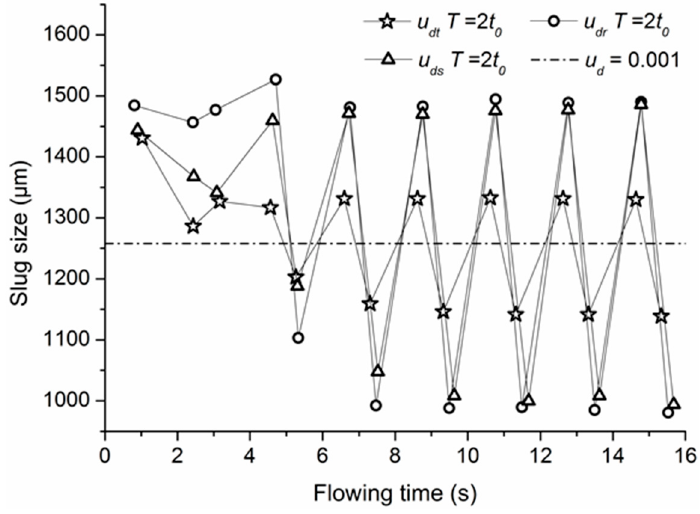
Figure 10. Slug size obtained from numerical simulations for dynamic dispersed injection flow rate of different types.